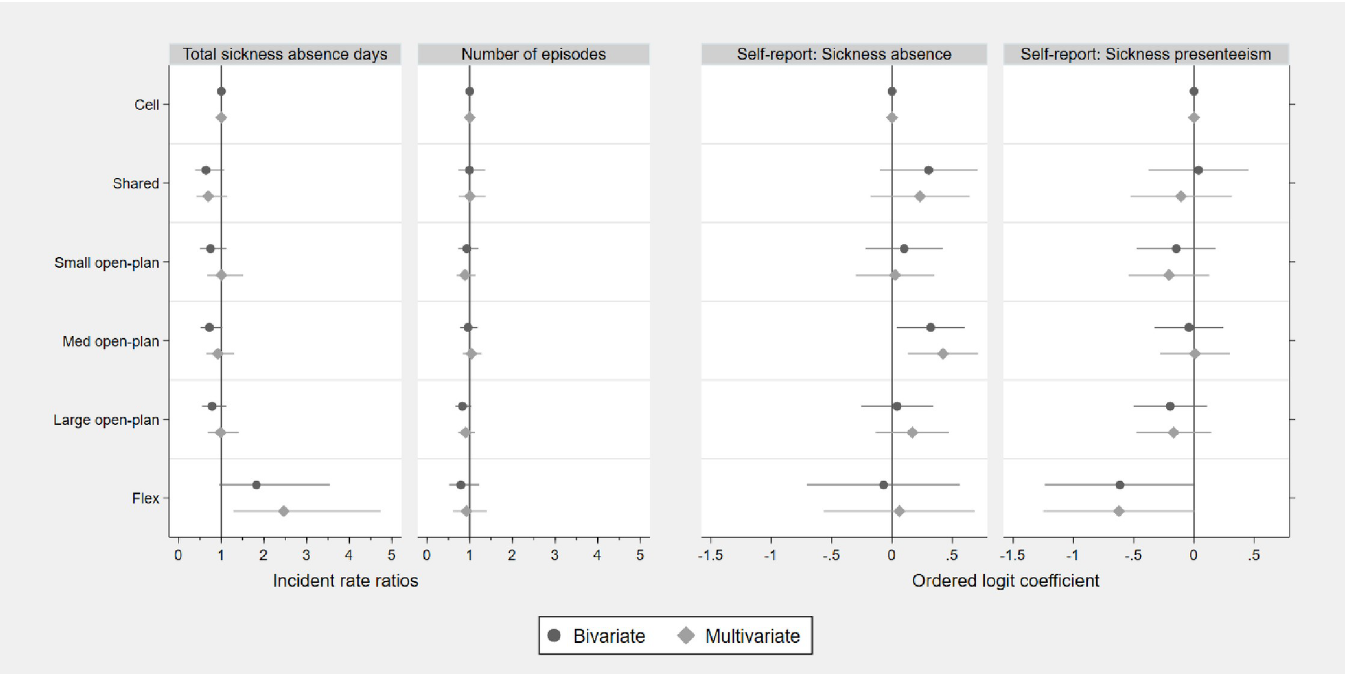
Fig 1. Associations between office type and employer records of days of sickness absence and number of episodes of sickness absence over the previous 12 months, n = 988, as well as self-reported days of sickness absence and sickness presence over the previous 12 months, n = 1237. Error bars indicate 95% confidence intervals. Multivariate estimates were generated after adjusting for gender, age, education level and public or private sector. Office types: Cell (1 workstation), shared (2–3 workstations), small open-plan (4–9 workstations), medium open-plan (10–24 workstations), large open-plan (over 24 workstations), flex (no allocated workstation).